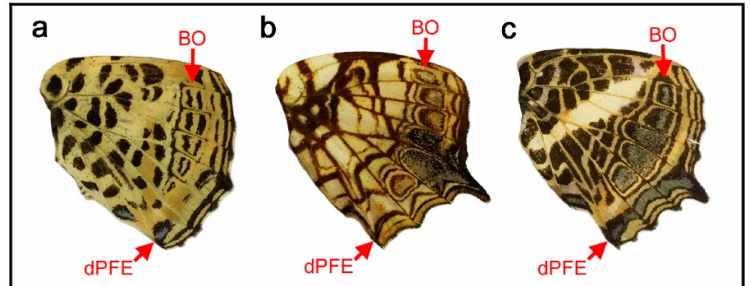
Figure 3. Diversity of band arrangements of the border symmetry system in the genus Symbrentha . BO: border ocelli, dPFE: distal parafocal element. ( a ) Symbrenthia leopard . ( b ) Symbrenthia hippoclus . ( c ) Symbrenthia hypselis